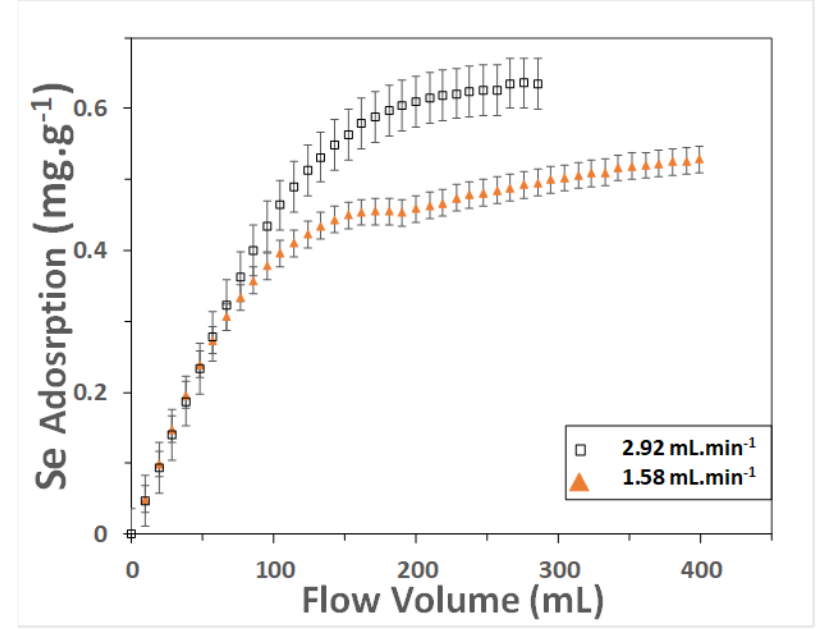
Figure 5. Se adsorption of column at differing flow rates to determine breakthrough times.